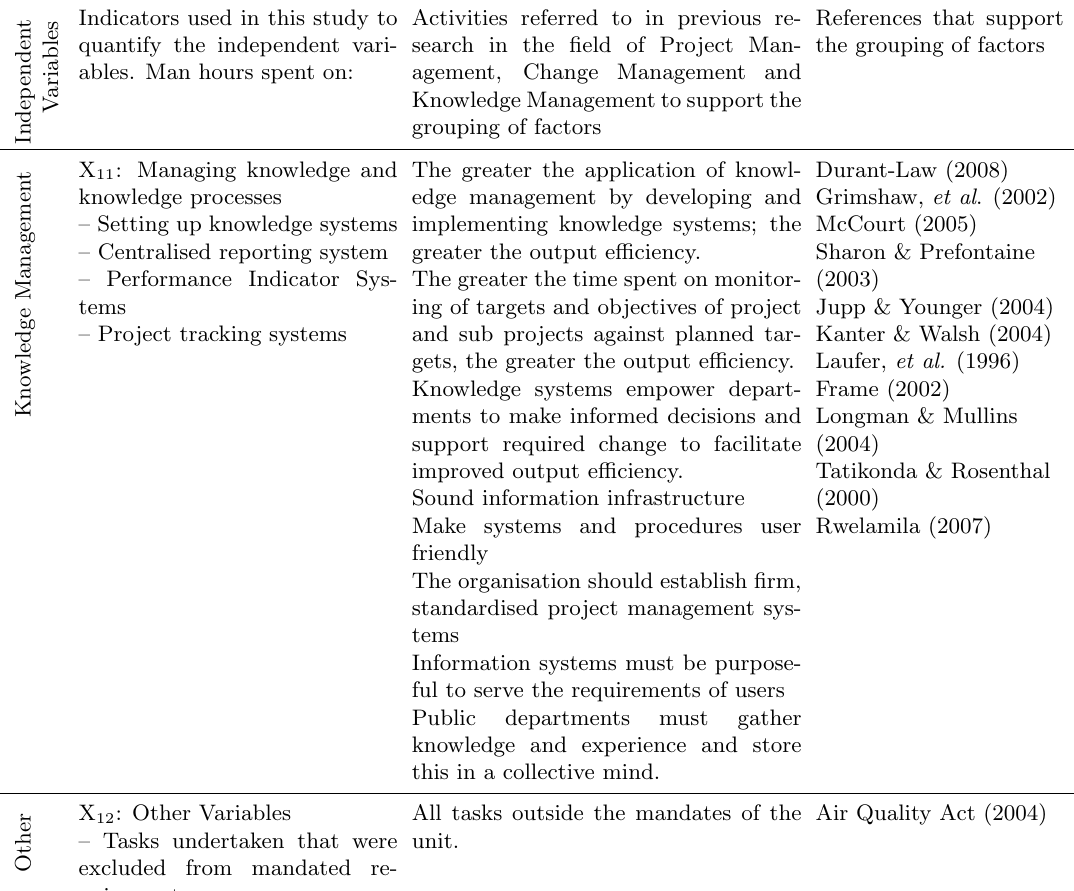
Selection of the input variables from the literature review on project management, change management and knowledge